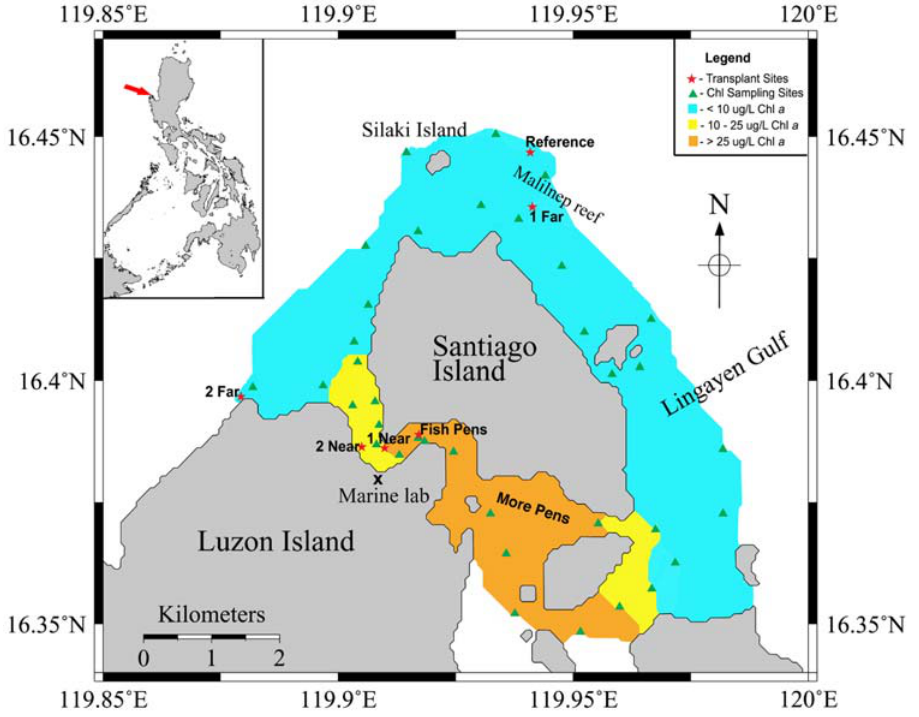
Figure 1. A map of the study sites and surface water invivo chlorophyll a measurements averaged over 4 consecutive weekly samplings. Note that transplant site ‘‘Fish Pens’’ did not have corals placed there since no live coral currently exists at that site. It was the location of all water and sediment sampling for the experiment as a representative fish pen.